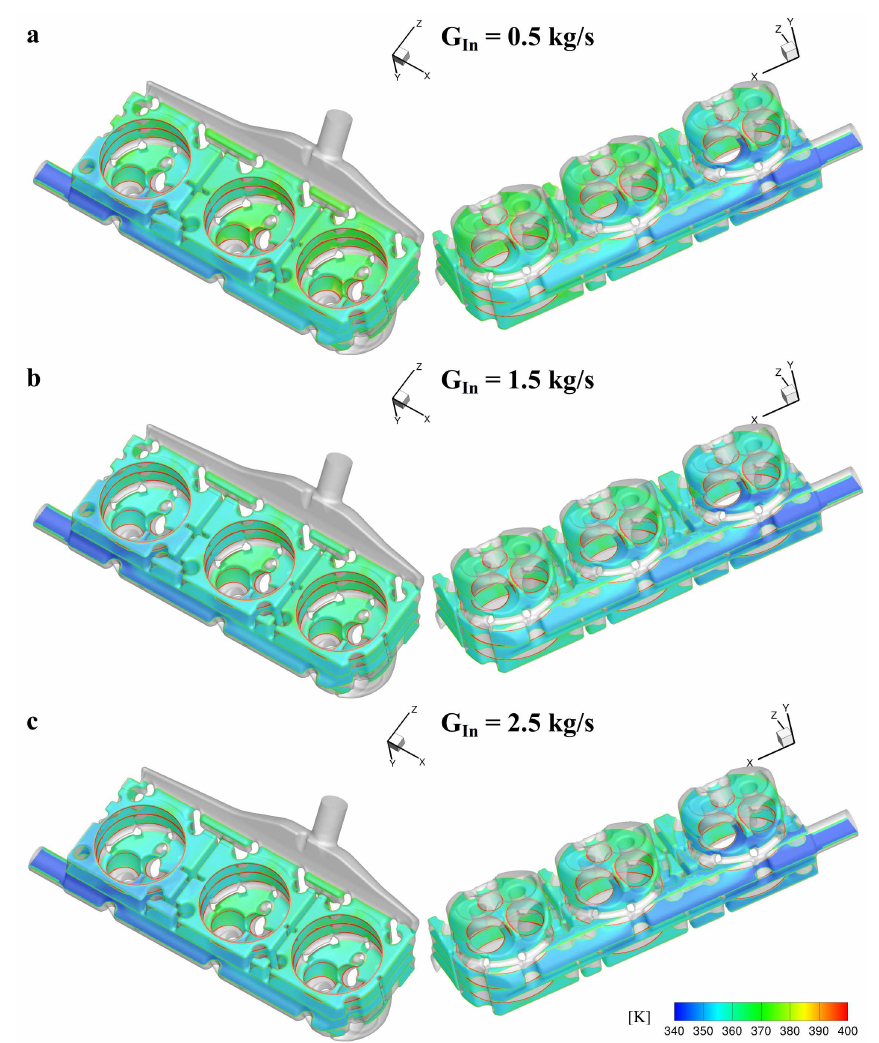
Figure 10. Temperature patterns for the new single-inlet geometry. Temperature contour plots obtained for T Cyls = 440 K and G In = 0.5 ( a ), 1.5 ( b ), and 2.5 ( c )